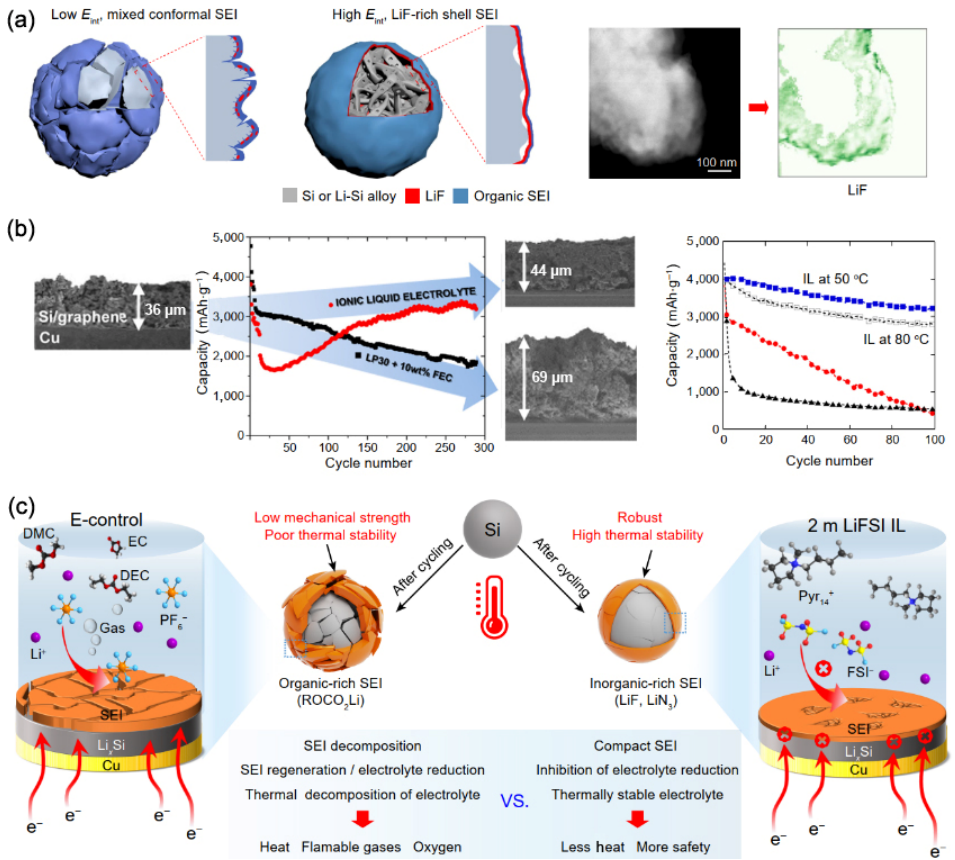
Figure 11 (a) Schematic diagram for the cycled alloy anode with an organic, low E int non-uniform and an inorganic, high E int and uniform Li alloy–SEI interface. Reproduced with permission from Ref. [167], © Chen, J. et al. under exclusive licence to Springer Nature Limited 2020. (b) Comparison of the cycling performance and cross-sectional SEM image of the Si/graphite electrode with and without an ionic liquid electrolyte. Reproduced with permission from Ref. [173], © American Chemical Society 2017. (c) Mechanisms for SEI affecting the battery safety in the E-control electrolyte and IL-based electrolyte at high temperatures. Reproduced with permission from Ref. [176], © Wiley-VCH GmbH